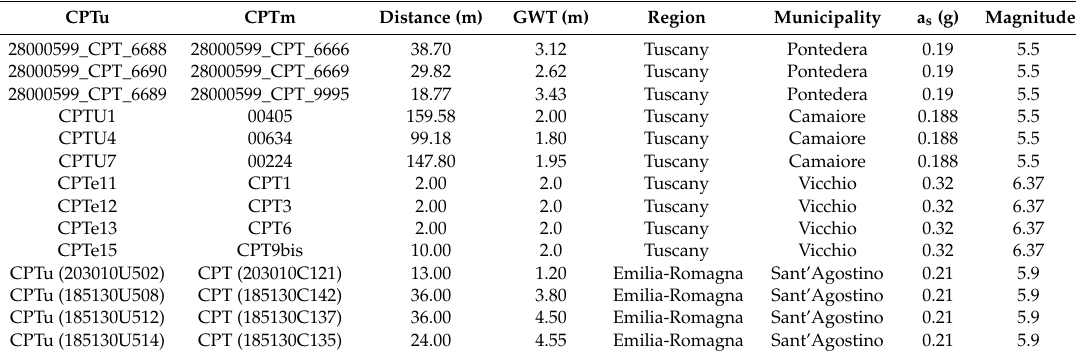
Table 6. Pairs of CPTm and CPTu in the study area (Tuscany region) and in Emilia-Romagna. CPTu CPTm Distance (m) GWT (m)